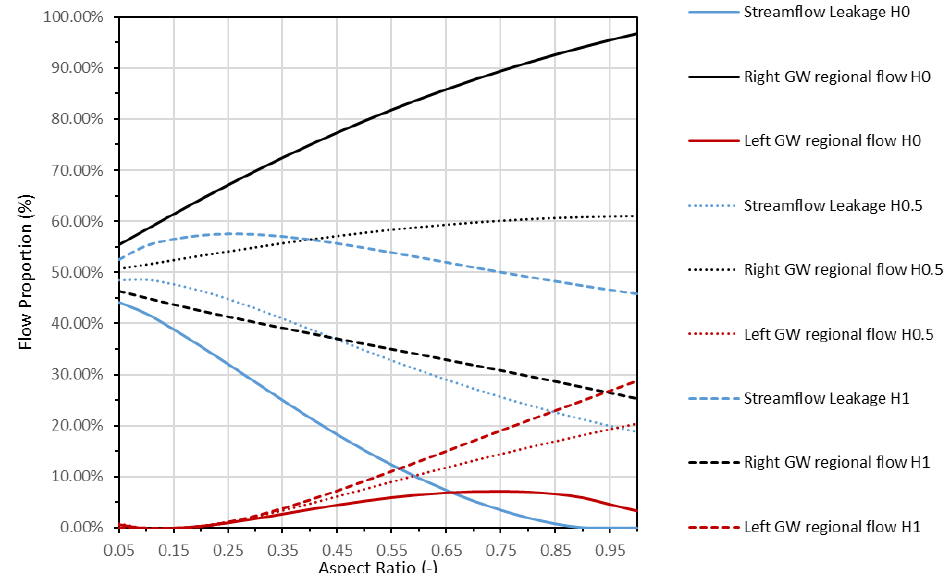
Figure 6. Evolution of the proportion of water in the pumping well with the aspect ratio and a variation in the right head boundary for Sim$2.1, Sim$2.2 and Sim$2.3.